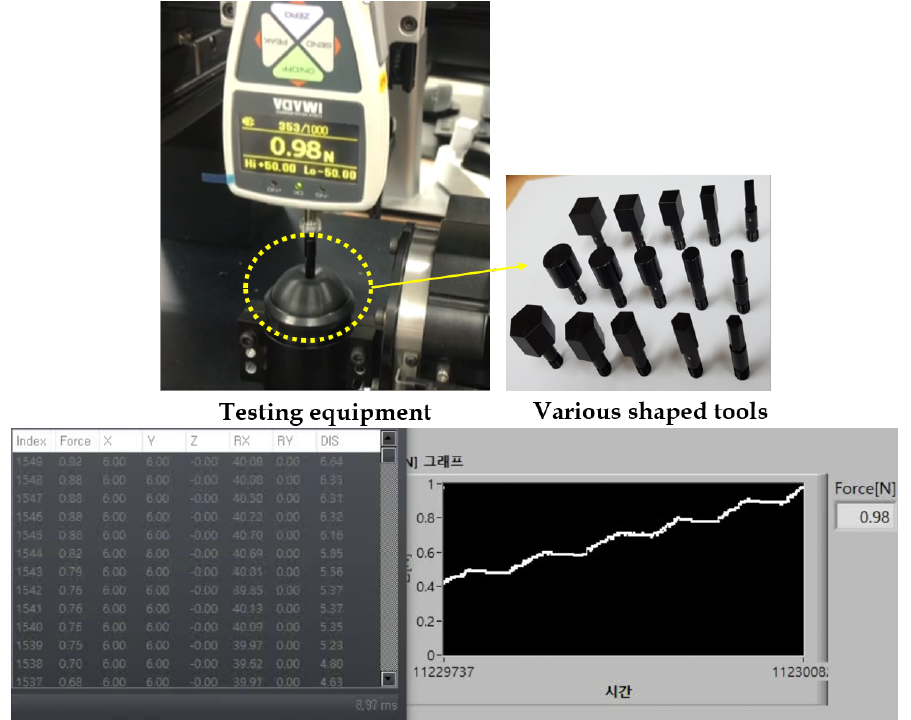
Figure 15. Testing scenarios and